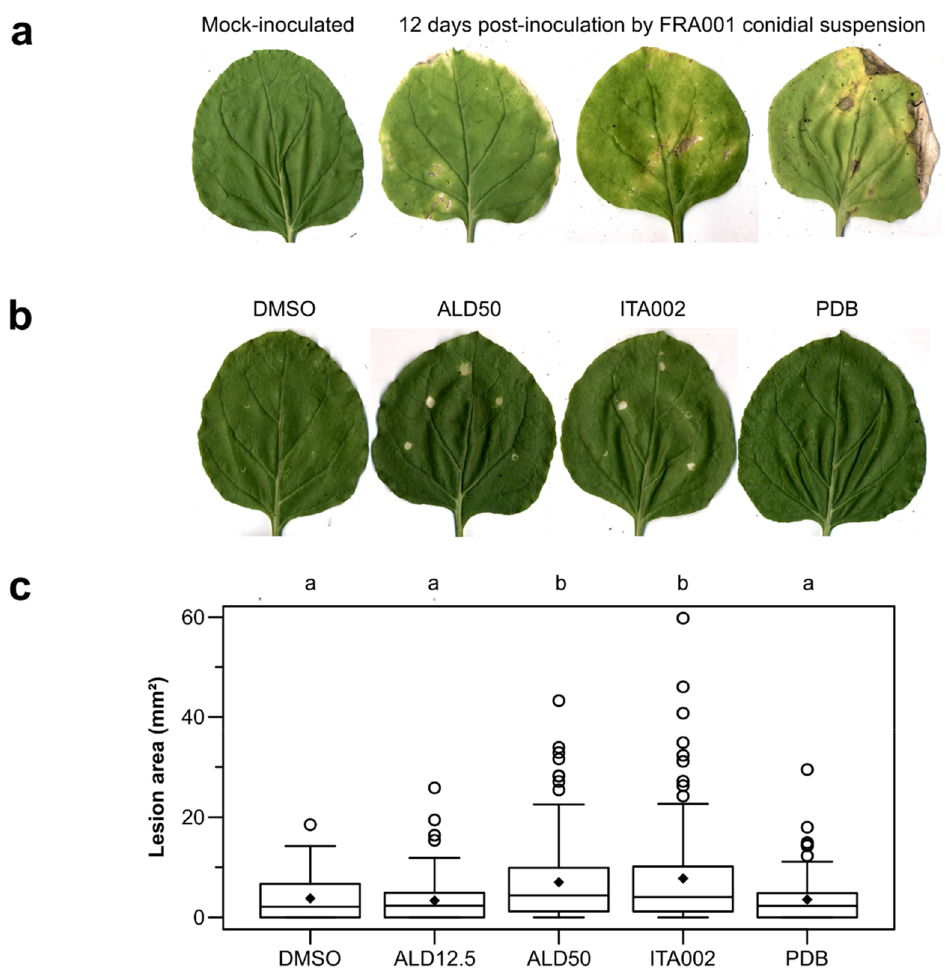
Figure 1. ( a ) N. benthamiana leaves 12 days post-inoculation by spreading FRA001 A. dauci strain conidial suspension with a paint brush. ( b ) N. benthamiana leaves 9 days after infiltration with various solutions. DMSO: 0.1% DMSO diluted in ultrapure water; ALD50: Aldaulactone at 50 µg mL −1 diluted in 0.1% DMSO solution; ITA002: organic phase of culture filtrate from ITA002 strain grown in PDB medium and diluted in 0.1% DMSO solution. ( c ) Lesion area distributions. Same legends as in B/ excepting ALD12.5: Aldaulactone at 12.5 µg mL −1 in 0.1% DMSO. Each box plot represents area distribution amongst 45 infiltrations (three independent repetition of 15 infiltration dots on 3 different plants). Diamonds represent the means. Letters represent the result of a Siegel and Castellan post-hoc test realized after a Kruskal–Wallis test ( p value = 2546.10 −6